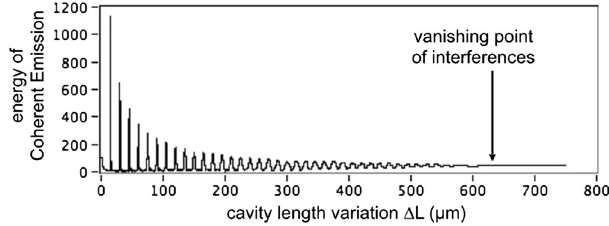
10. Coherent emission vs cavity length detuning, within the expanded range, showing vanishing interferences at Δ L ¼ 630 μ m when using the parameters of CLIO: N